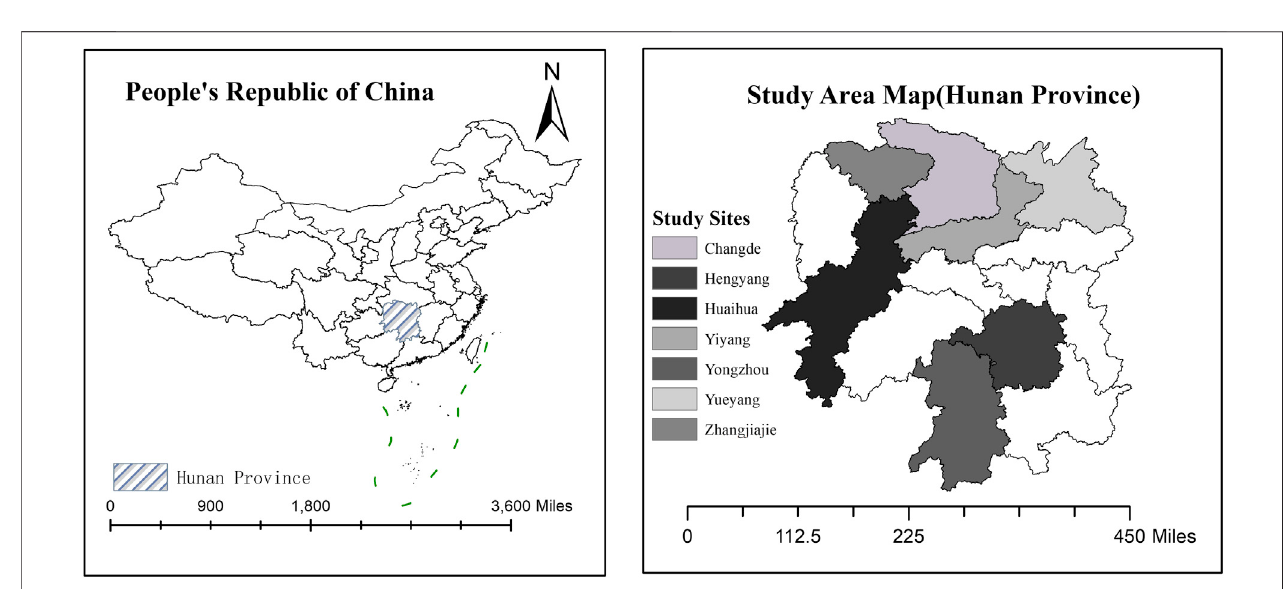
FIGURE 2 | Map of the study